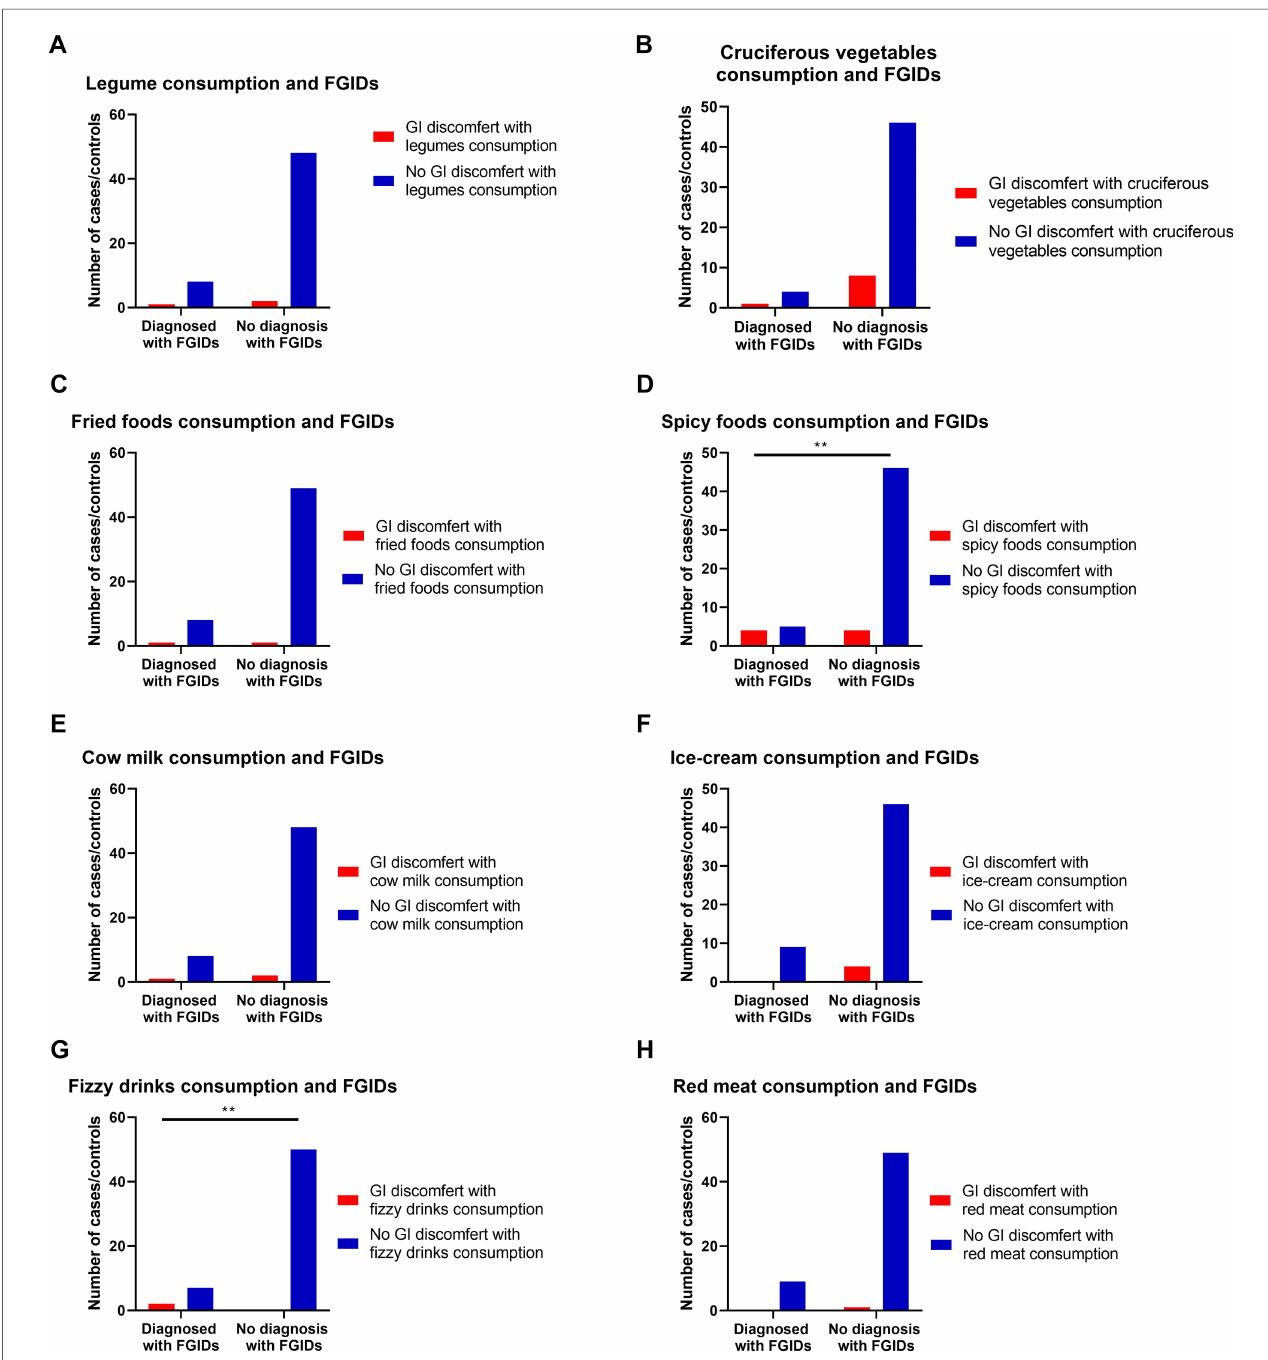
FIGURE 1 The relationship between the most common FGIDs and family history of gastrointestinal (GI) diseases. Data represent frequency ( n =59) of ( (cid:129) ) cases and ( (cid:129) ) controls of ( A ) functional dyspepsia and family history of peptic ulcers, ( B ) Functional abdominal pain and family history of abdominal pain, ( C ) Functional constipation and family history of constipation, ( D ) functional vomiting and family history of vomiting, ( E ) irritable bowel syndrome and family history of irritable bowel syndrome (IBS), and ( F ) Functional aerophagia and family history of a Aerophagia. Chi-square test was used to test the relative risk of family history of certain diseases and their possible accompanied FGIDs. Data at which values differed signi fi cantly, * p ≤ 0.05, ** p ≤ 0.01, *** p ≤